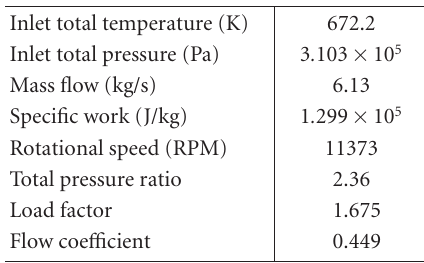
Table 2: Flow conditions in the NASA test turbine.